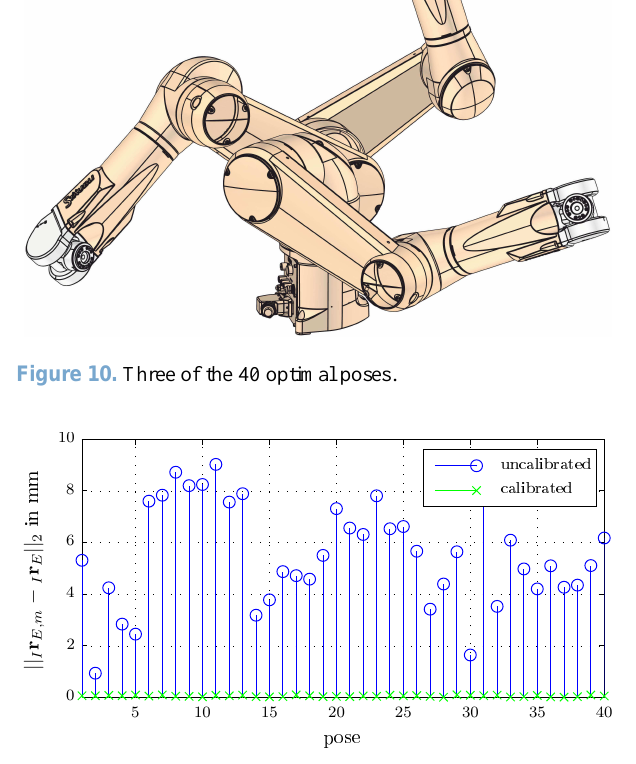
Figure 11. Absolute error of the end-effector for the calibration poses.